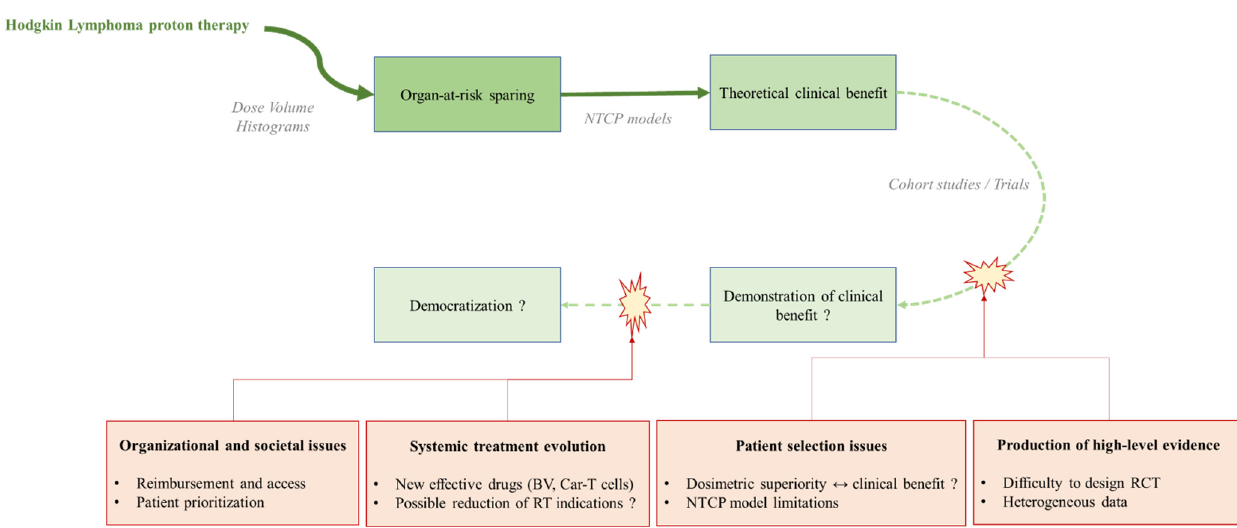
Figure 2. Current challenges for wider Hodgkin lymphoma (HL) implementation. The theoretical benefit of proton ther- apy for Hodgkin lymphoma in terms of toxicity reduction is accepted (based on dosimetric comparisons or NTCP models); however, production of high-level evidence is complex: HL is a rare disease for which late radiation-induced toxicity evaluation requires long-term follow-up. In addition, the optimal patient selection process is subject to debate, since dosi- metric superiority does not necessarily translate into clinical benefit and that NTCP models have limitations. Furthermore, CD30 car-T cells (for relapse/refractory disease) which might possibly lead to a reduction of RT indications in HL man- agement in the future. Organizational issues (such as prioritization of patients in a proton therapy center) and societal